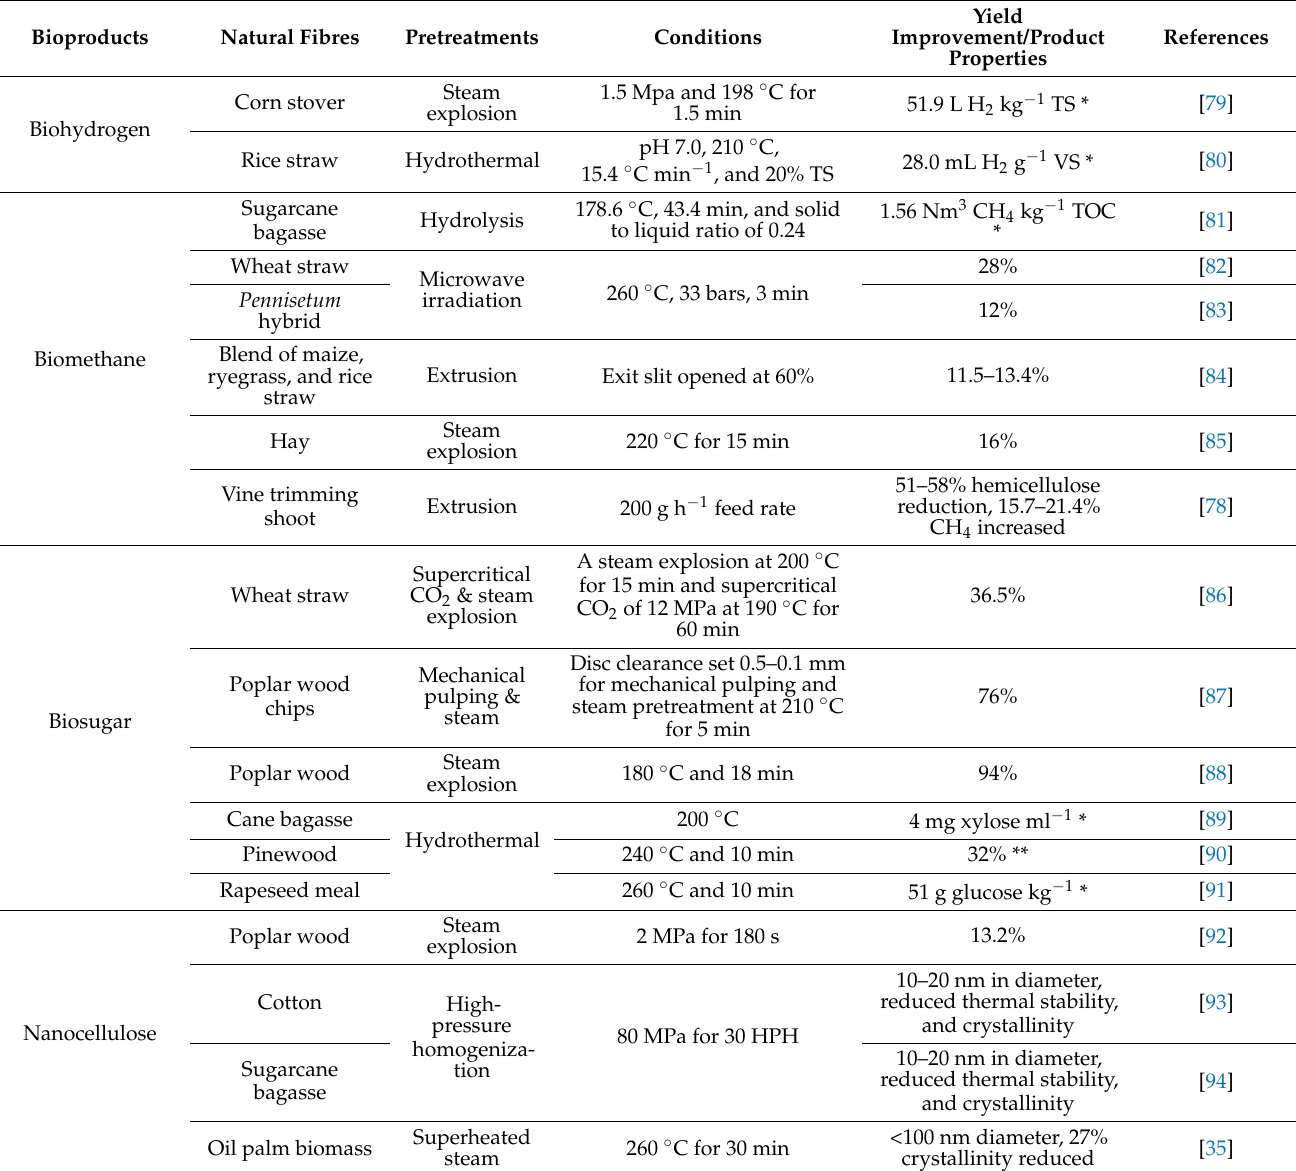
Table 5. A summary of physical pretreatments applied for numerous